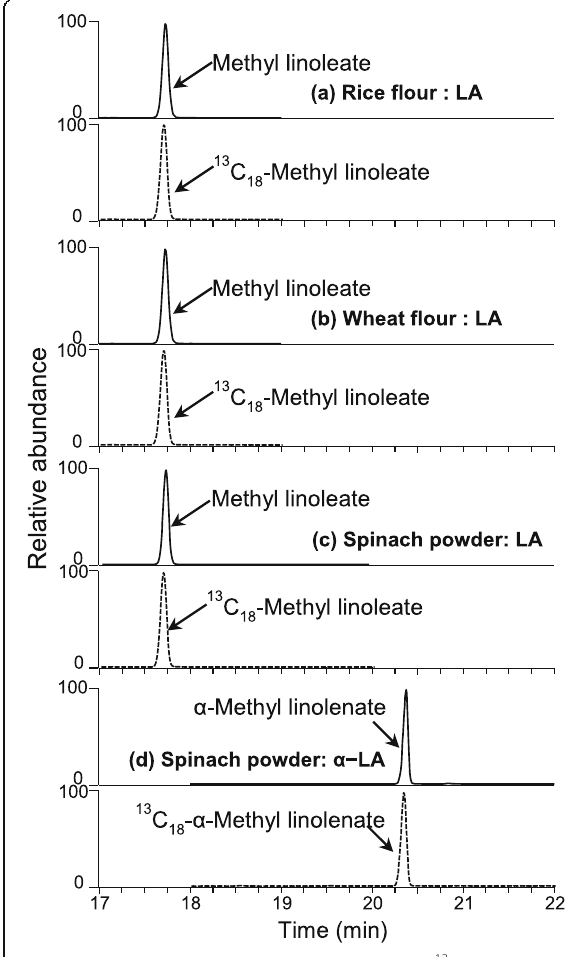
Fig. 2 SIM chromatograms of methyl linoleate and 13 C 18 methyl linoleate extracted from ( a ) rice flour, ( b ) wheat flour, and ( c ) spinach powder and ( d ) SIM chromatograms of α -methyl linolenate and 13 C 18 - α -methyl linolenate extracted from spinach powder